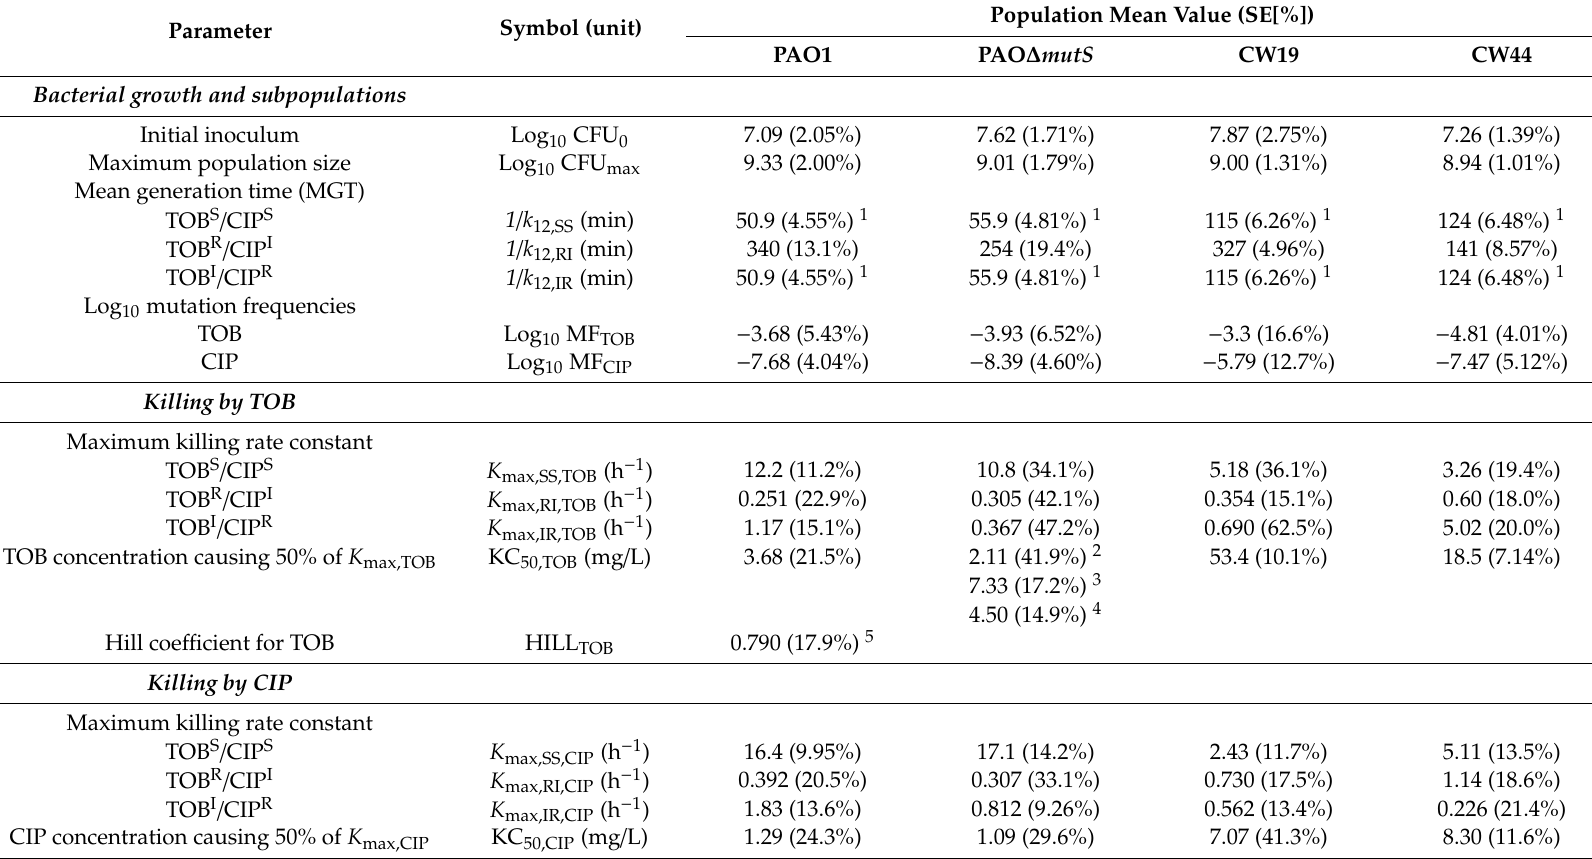
Table 2. Population mean (SE %) parameter estimates for the mechanism-based model (MBM) evaluation of static concentration time-kill (SCTK) experiments assessing the tobramycin (TOB) with ciprofloxacin (CIP) combination against non-hypermutable P. aeruginosa PAO1 and hypermutable PAO ∆ mutS , CW19, and CW44. All parameters described were required for the MBM to achieve unbiased and precise curve